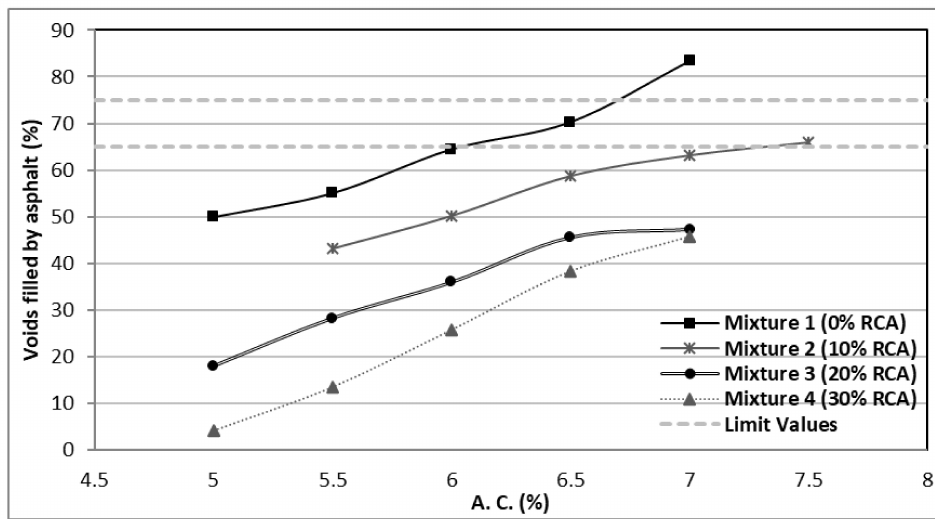
Figure 11. Voids percentage filled by asphalt in the